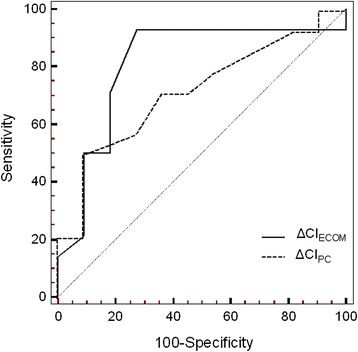
ROC curves showing the relationship between sensitivity and specificity in determining the discrimination of ΔCIPCand ΔCIECOMin predicting fluid responsiveness. The dotted diagonal line is the no-discrimination curve. No significant difference was found between ROC curves. ΔCIECOM = change in cardiac index ECOM during passive leg raising; ΔCIPC = change in cardiac index pulse contour analysis during passive leg raising; ROC = receiver operating characteristic curve.